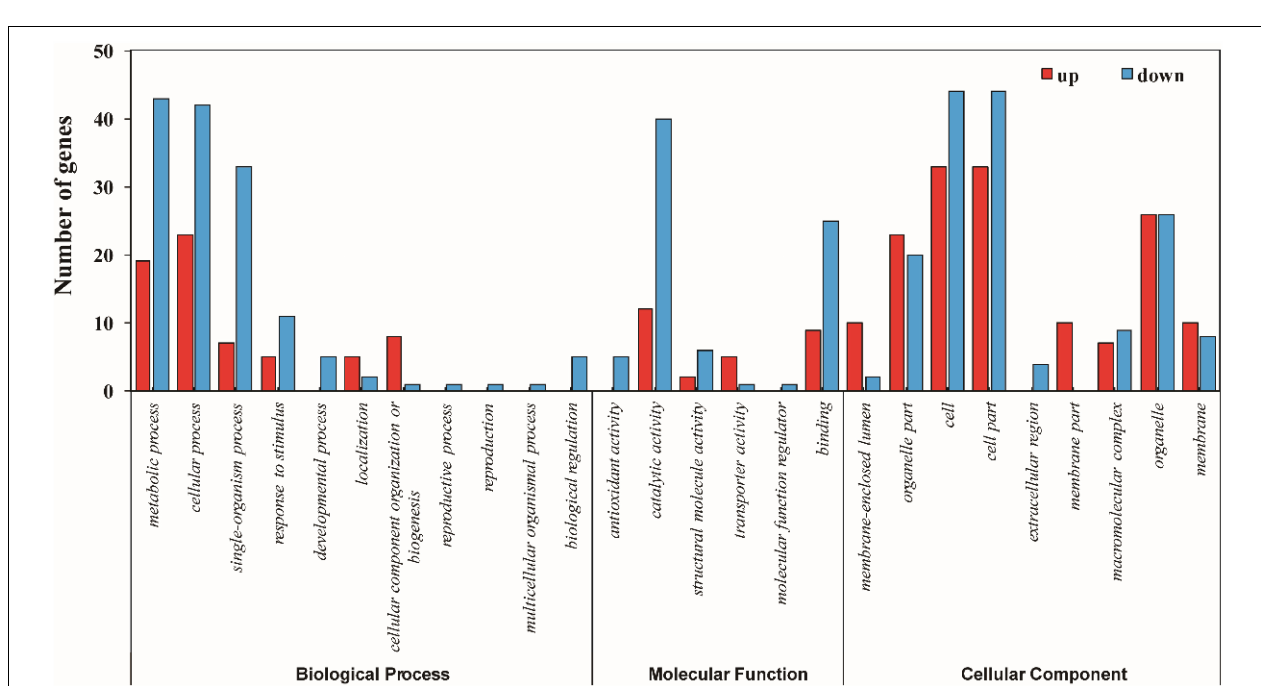
FIGURE 4 | GO annotation of differentially expressed proteins between XM 55 and YM 158 under WL.